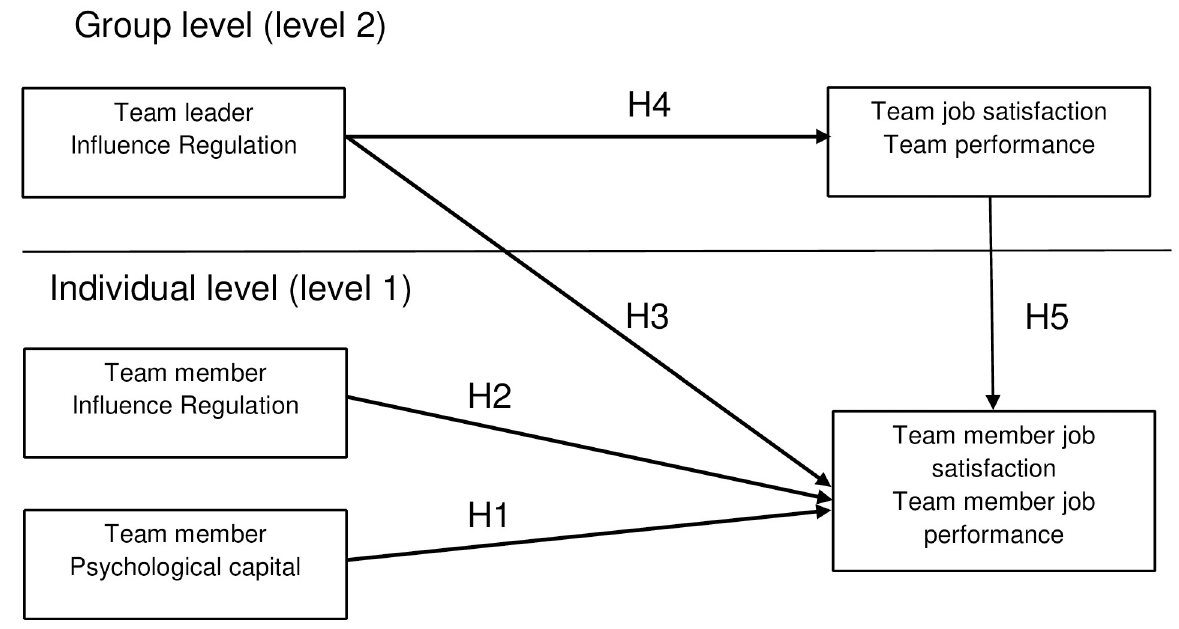
Fig 1. Proposed multilevel research